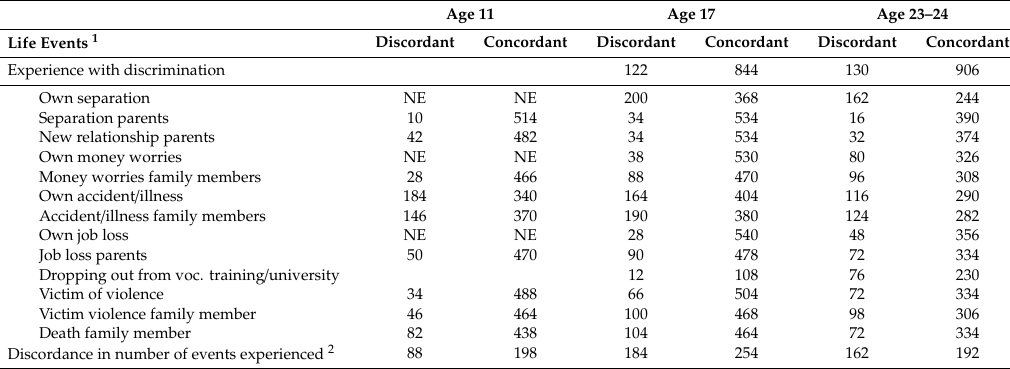
Table 1. Discordance between monozygotic (MZ) twins: occurrence of life events (based on valid information for both twins only)